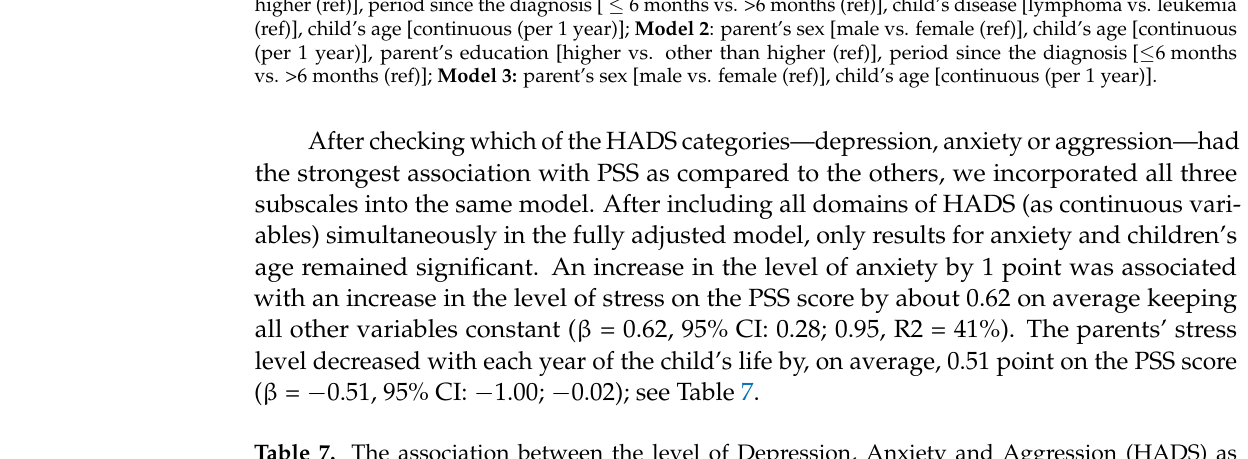
Table 7. The association between the level of Depression, Anxiety and Aggression (HADS) as continuous variables and the level of stress (PSS score and stens)—model of multivariable regression common for all HADS